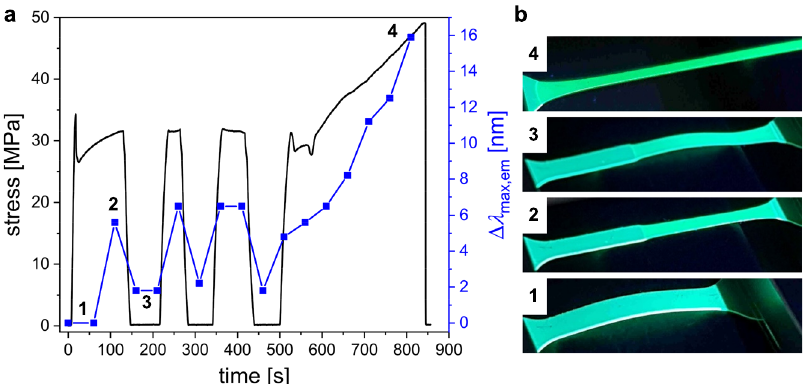
Fig. 6 Reversibility of the mechanochromic response. a Stress vs. time curve (black) of o -DPP 6a during a stress-strain experiment with three relaxation breaks via negative elongation (5 mm min − 1 for both directions). The corresponding shifts Δ λ max,em (blue) from PL-spectroscopy were correlated to the stress values by the time. b Images of the specimen under UV-light (365 nm) at the four indicated positions in the stress-time